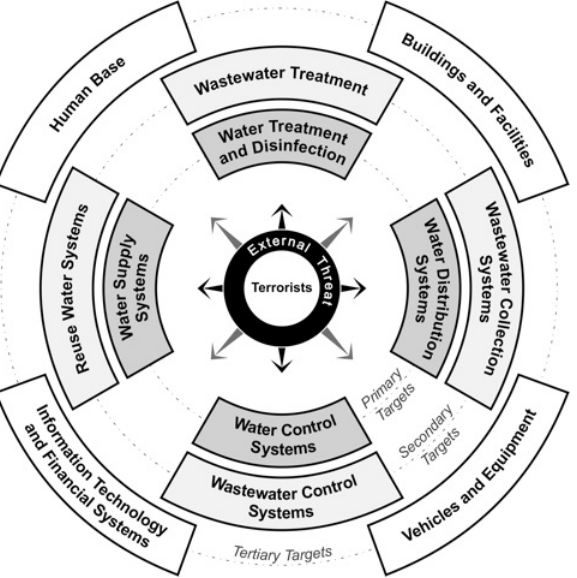
Figure 3: Potential terrorist attack targets in water critical